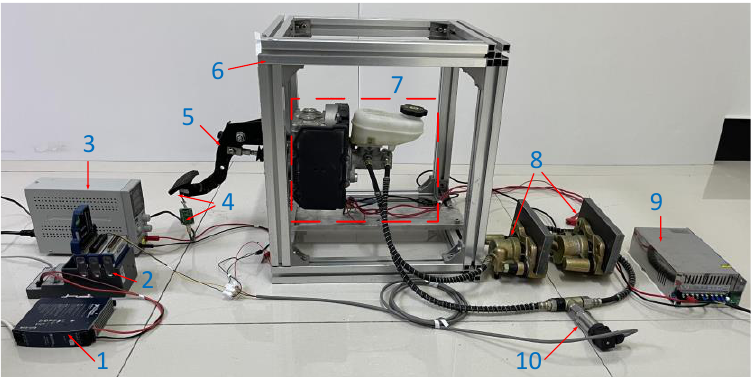
Figure 4. Brake data acquisition test bench: 1. NI acquisition card chassis, 2. NI acquisition card, 3. DC power supply, 4. WT901CM attitude sensor, 5. brake pedal, 6. test bench bracket, 7. Bosch ’ s electric-assisted braking system, 8. brake caliper, 9. DC power supply, 10. oil pressure sensor.